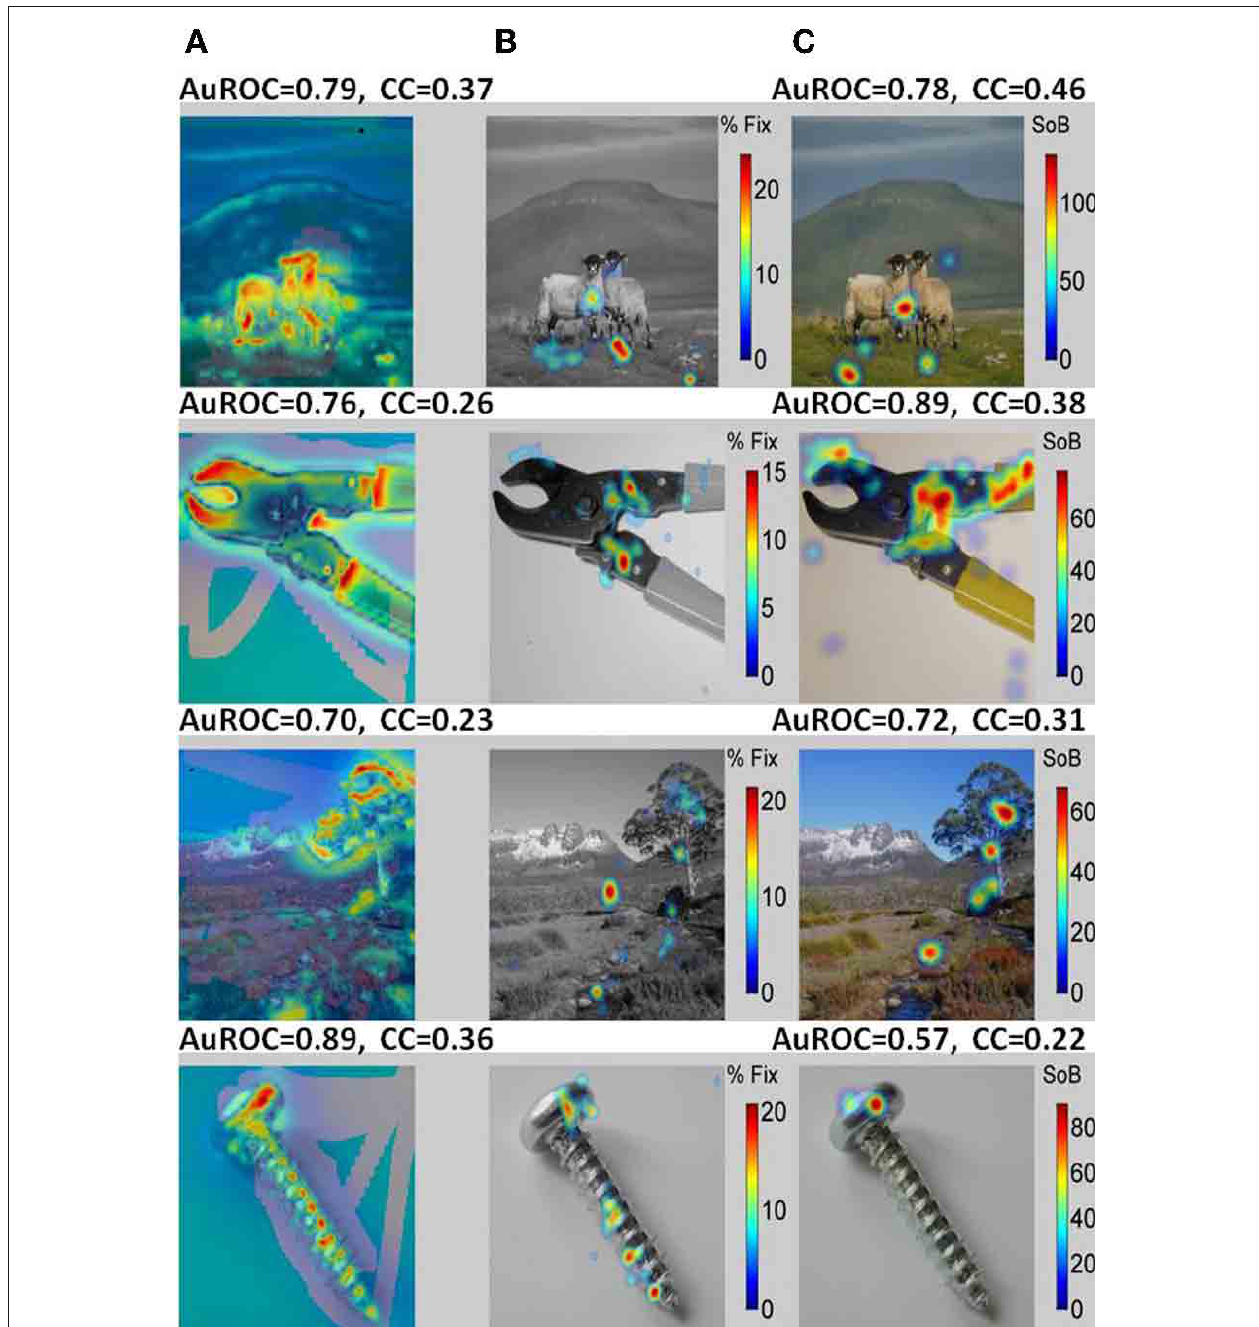
FIGURE 8 | A bottom-up saliency map (VSM) is a good predictor of fixations on natural images or objects. (A) Examples of the natural images seen by the monkeys with VSM overlaid on top. The VSM is computed from the image features according to Itti and Koch saliency map model. (B) Summary Fixation HotSpot maps for multiple presentations of the same image thresholded to emphasize pixels receiving the longer fixations across image repetitions. The map is constructed from averaging and smoothing the scanpaths executed by the viewer over each image presentation and indicates places in the image that were behaviorally salient for the viewer and hence repeatedly visited. (C) Amygdala Saliency model (ASM) generated from the firing of ensembles of cells in the amygdala. Colors in the image